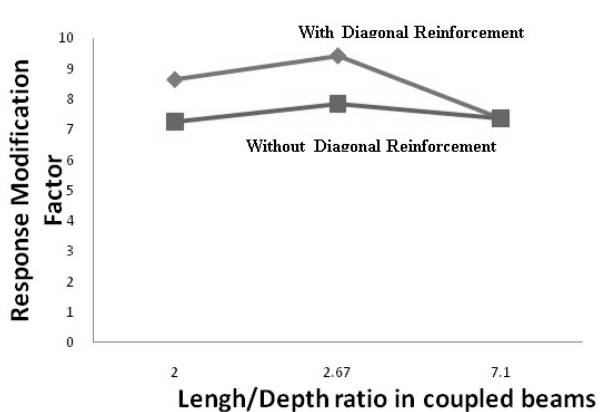
Fig. 11. Variation of the response modification